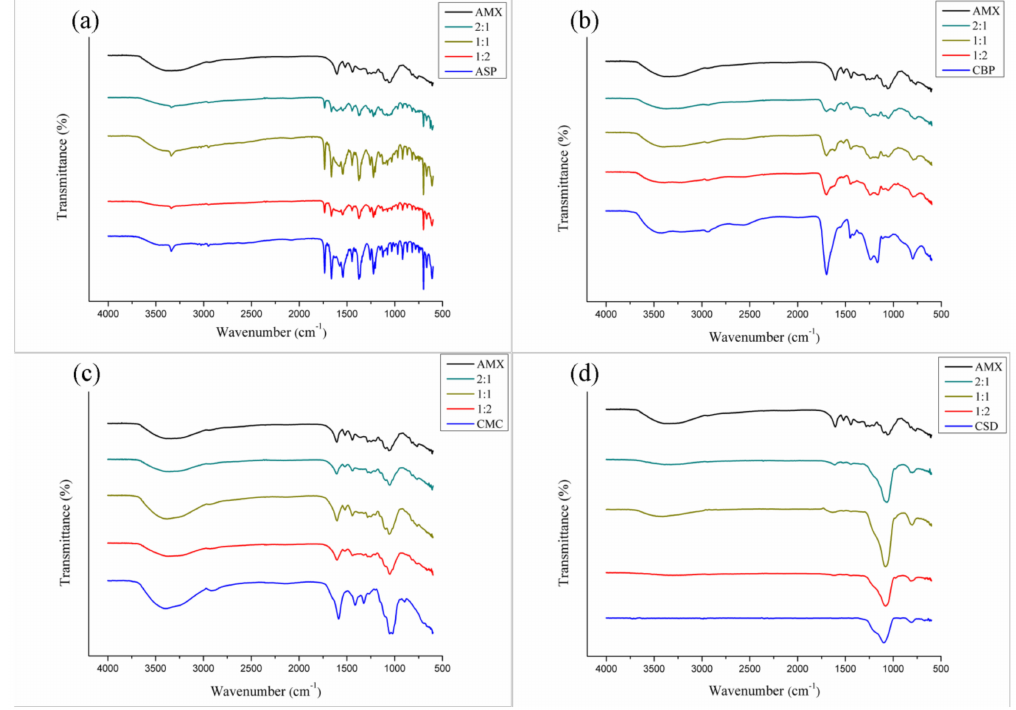
Figure 5. FTIR spectra for AMX and mixtures thereof with pharmaceutical excipients: aspartame ( a ), carbopol ( b ), carboxymethylcellulose ( c ), and colloidal silicon dioxide ( d